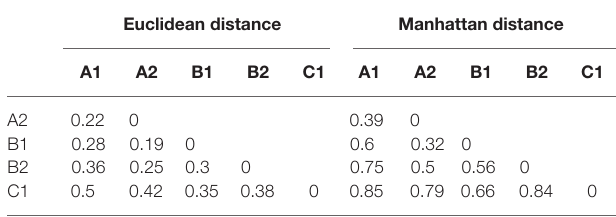
TABLE 4 | Euclidean and Manhattan distances among the five EFCAMDAT2 sub-corpora. Euclidean distance Manhattan